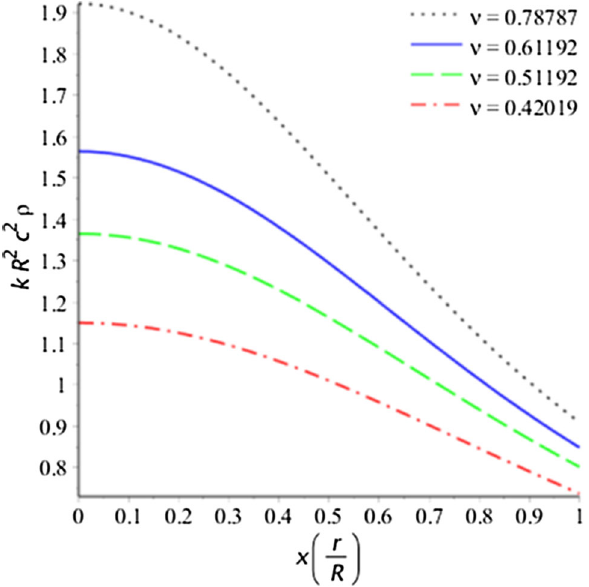
Fig. 1 Graphical representation of the density